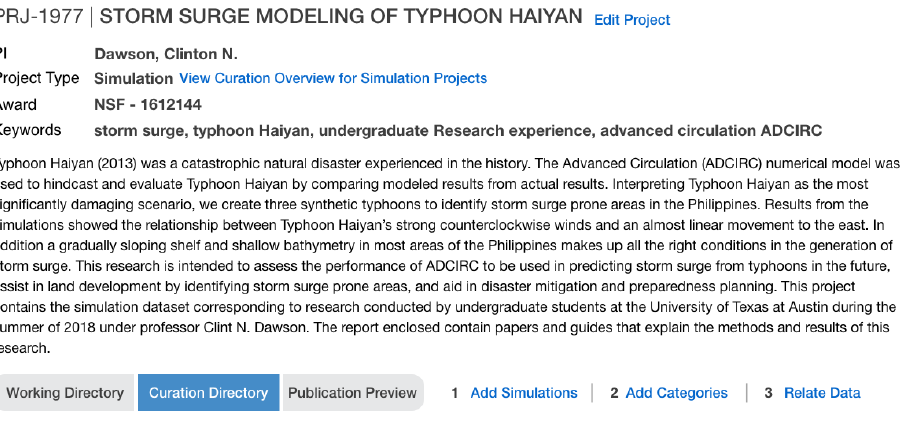
Figure 3. My Project space where users create projects and work in teams. In the snapshot, the Curation Directory is highlighted, and the three steps entailed in curation appear to the right.